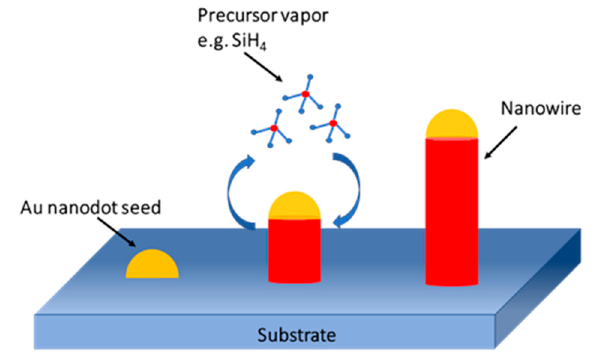
Figure 23. Schematic of VLS growing nanowires [117].